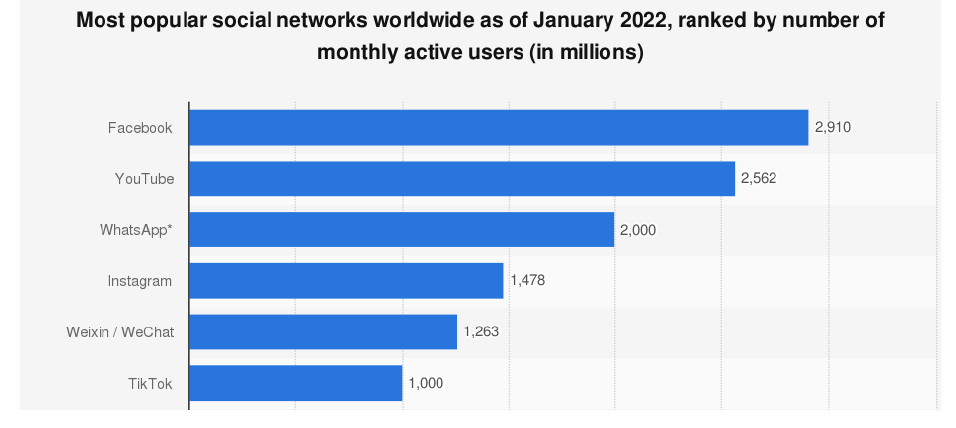
Fig. 2 Social Media Users 2022 Source: Statista.com